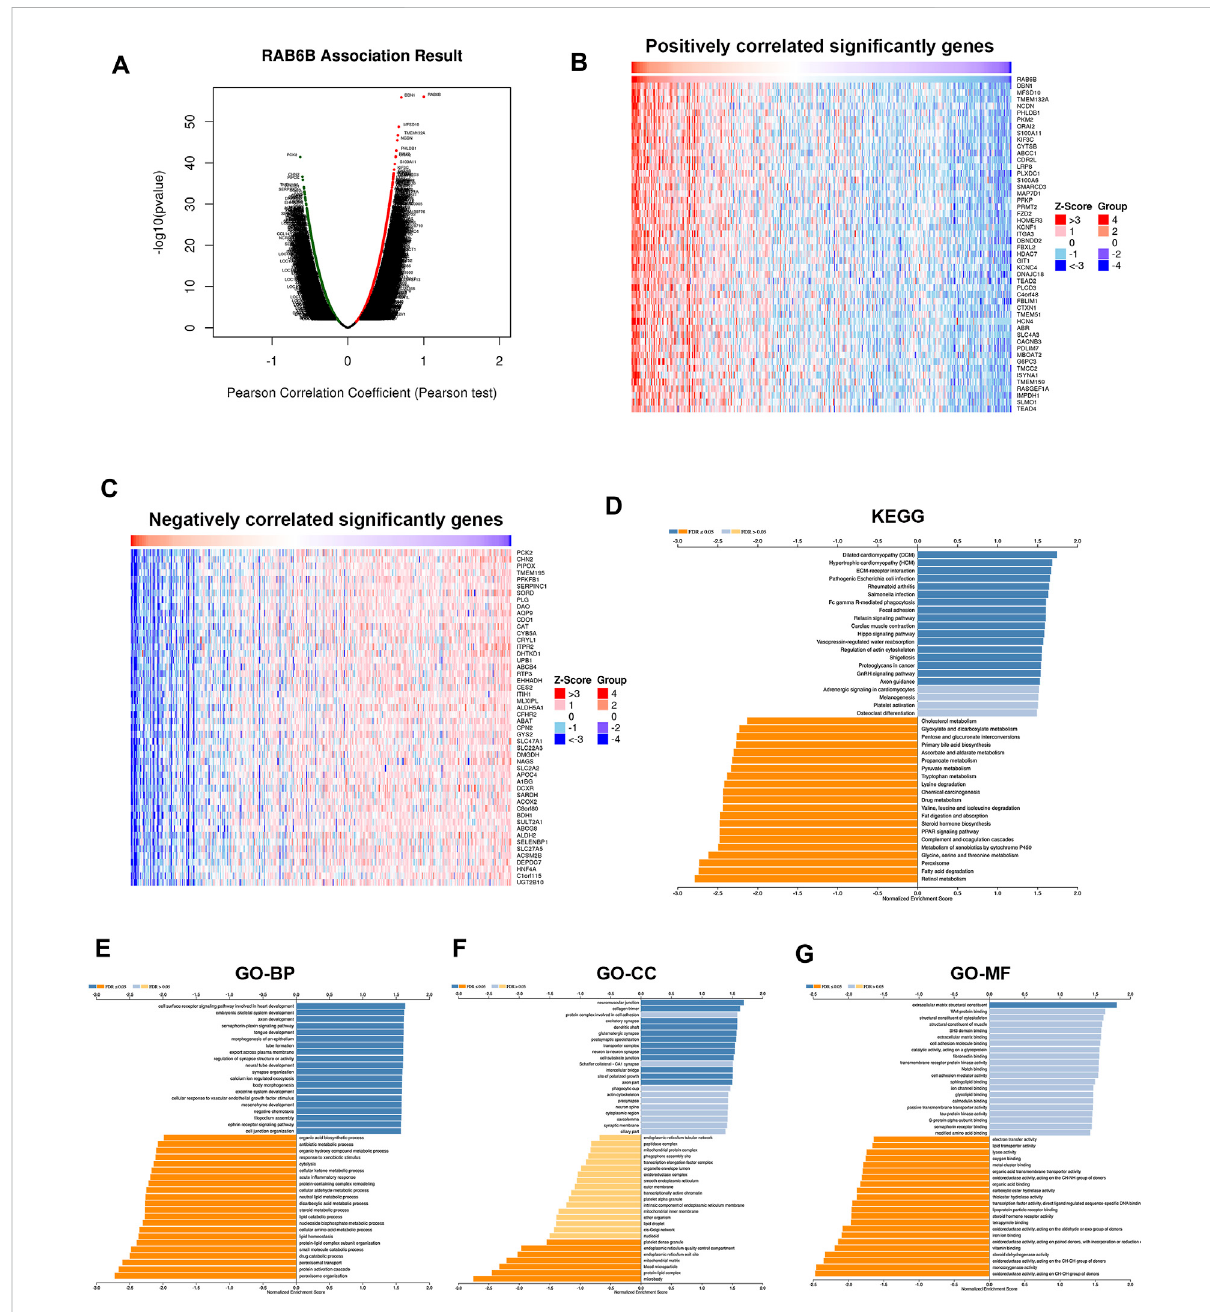
FIGURE 6 Functional enrichment analysis of RAB6B-related genes. (A) The Volcano plot showed RAB6B co-expressed gene pro fi le in HCC bythe LinkedOmics database. (B,C) Heatmap showed 50 positively (B) and 50 negatively (C) correlated genes with RAB6B expression in HCC. (D) KEGG analysisofRAB6Bco-expressedgenesinHCC.KEGG,KyotoEncyclopediaofGenesandGenomes. (E – G) VarioustypesofGOanalysisofRAB6Bco- expressed genes in HCC. GO, Gene Ontology; BP, Biological Process; CC, Cellular Component; MF, Molecular